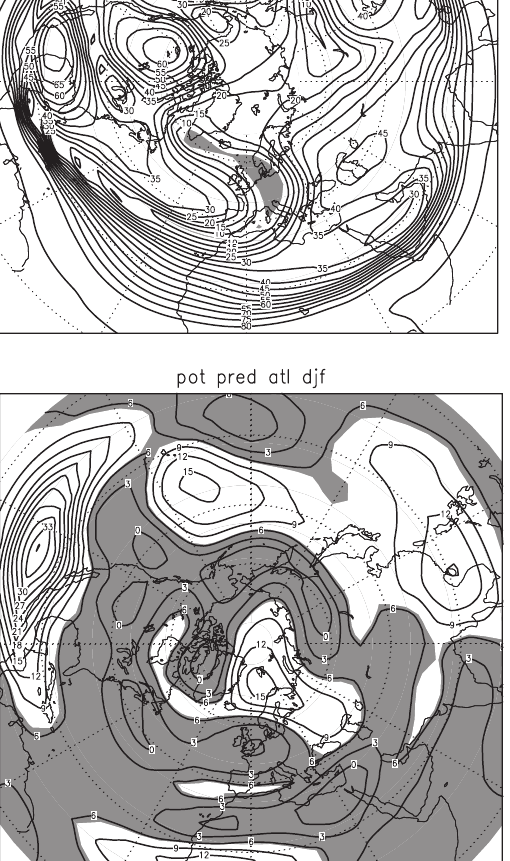
Fig. 4. Potential predictability (% of total variance) for winter (DJF) 500-hPa geopotential height in GLOBAL, NOATL and ATL. Shaded regions indicate non-significant zone according to an F test (see